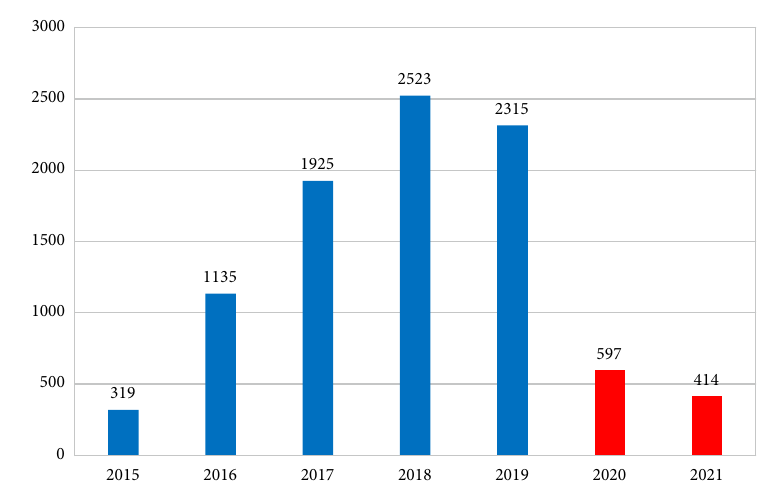
Figure 4. Average annual number of transactions carried out in the system between 2015 and 2021 (in Zielony) (source: own elaboration based on Stępnicka et al., 2021; data obtained from the administrator of the Zielony complementary currency system in